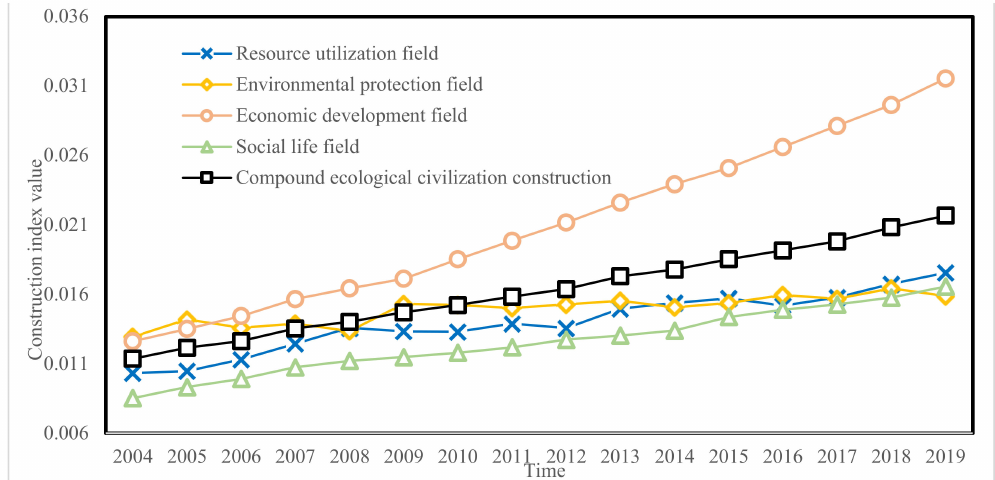
Figure 3. Ecological civilization construction index in four fields from 2004 to